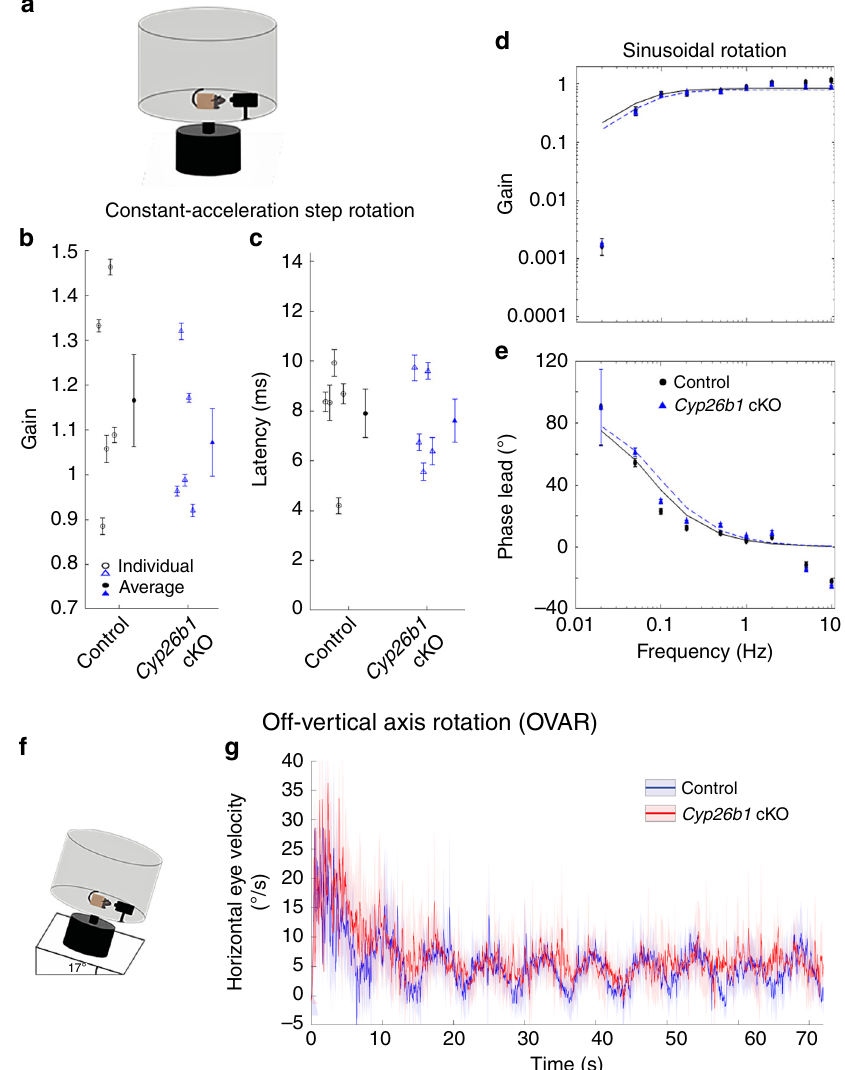
Fig. 7 Normal aVOR and OVAR responses in Cyp26b1 cKO mice. a Schematic view of aVOR apparatus. Constant-acceleration step gain G A ( b ) and latency ( c ) for aVOR responses to whole-body, 3000°/s 2 whole-body passive yaw rotations in darkness about an Earth-vertical axis through the head. Open markers denote individual mice; thick markers and lines show mean ± SEM. Gain ( d ) and phase lead ( e ) for yaw slow-phase aVOR responses to 0.02 – 10 Hz, 100°/s peak velocity sinusoidal, whole-body passive yaw rotations. Solid and dashed lines show fi rst-order high-pass fi lter model fi ts to control and Cyp26b1 cKO mouse population data, respectively. The high variability of phase and 0.02 Hz and relatively poor fi t to gain data at 0.02 Hz are due to the small amplitude of responses at that frequency. Differences between control and Cyp26b1 cKO mice were not signi fi cant for G A , latency, model gain, or table was maintained at 17°. g No signi fi cant difference in the eye velocity was observed between control and Cyp26b1 cKO mice during transient response (~20 s; amplitude: 43.8 ± 8.3 vs. 38.7 ± 7.4° ( P = 0.66, unpaired t test), time constant: 4.1 ± 1.1 vs. 5.1 ± 2.3 s ( P = 0.68, unpaired t test), when both semicircular canal and otolith organs are stimulated, and steady-state response (~20 s; amplitude: 5.3 ± 0.72 vs. 5.8 ± 0.75° ( P = 0.64, unpaired t test), bias: 10.5 ± 1.3 vs. 8.5 ± 1.3 ( P = 0.33, unpaired t test), time when only responses from otolith organs are expected to be